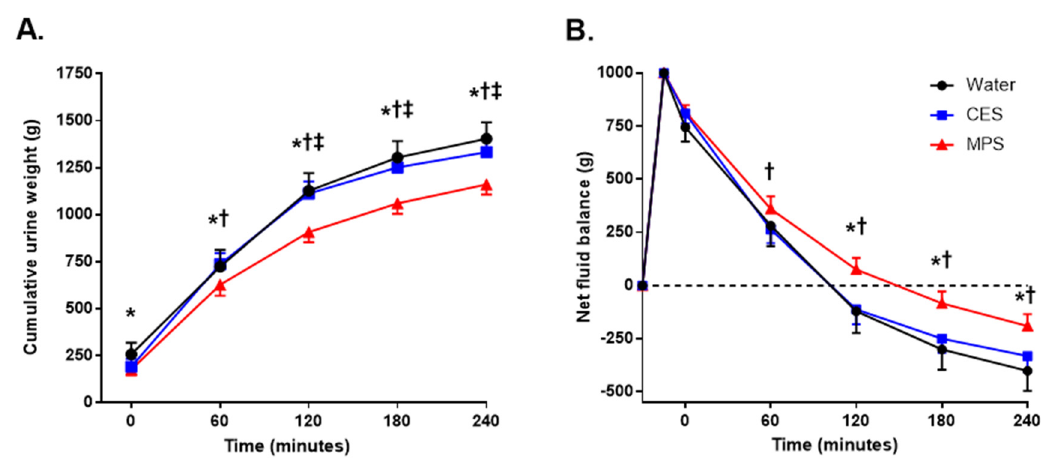
Figure 2. Cumulative urine output ( A ) and net fluid balance ( B ) 4 h after consumption of water, a carbohydrate–electrolyte solution (CES), and a milk permeate-based solution (MPS). Cumulative urine output was significantly lower in MPS compared to both water and CES at all time points after ingestion and was lower in CES compared to water beginning at 120 min. Net fluid balance was more positive for MPS compared to water and CES from 2 h onward. There were no differences in net fluid balance between the water and CES trials. Values are means ± SD. Differences among beverages were assessed by two-way ANOVA. * p < 0.05 MPS compared to water; † p < 0.05 MPS compared to CES; ‡ p < 0.05 CES compared to water.